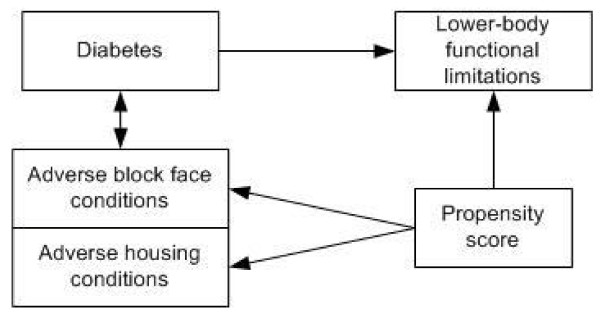
Conceptual Model.